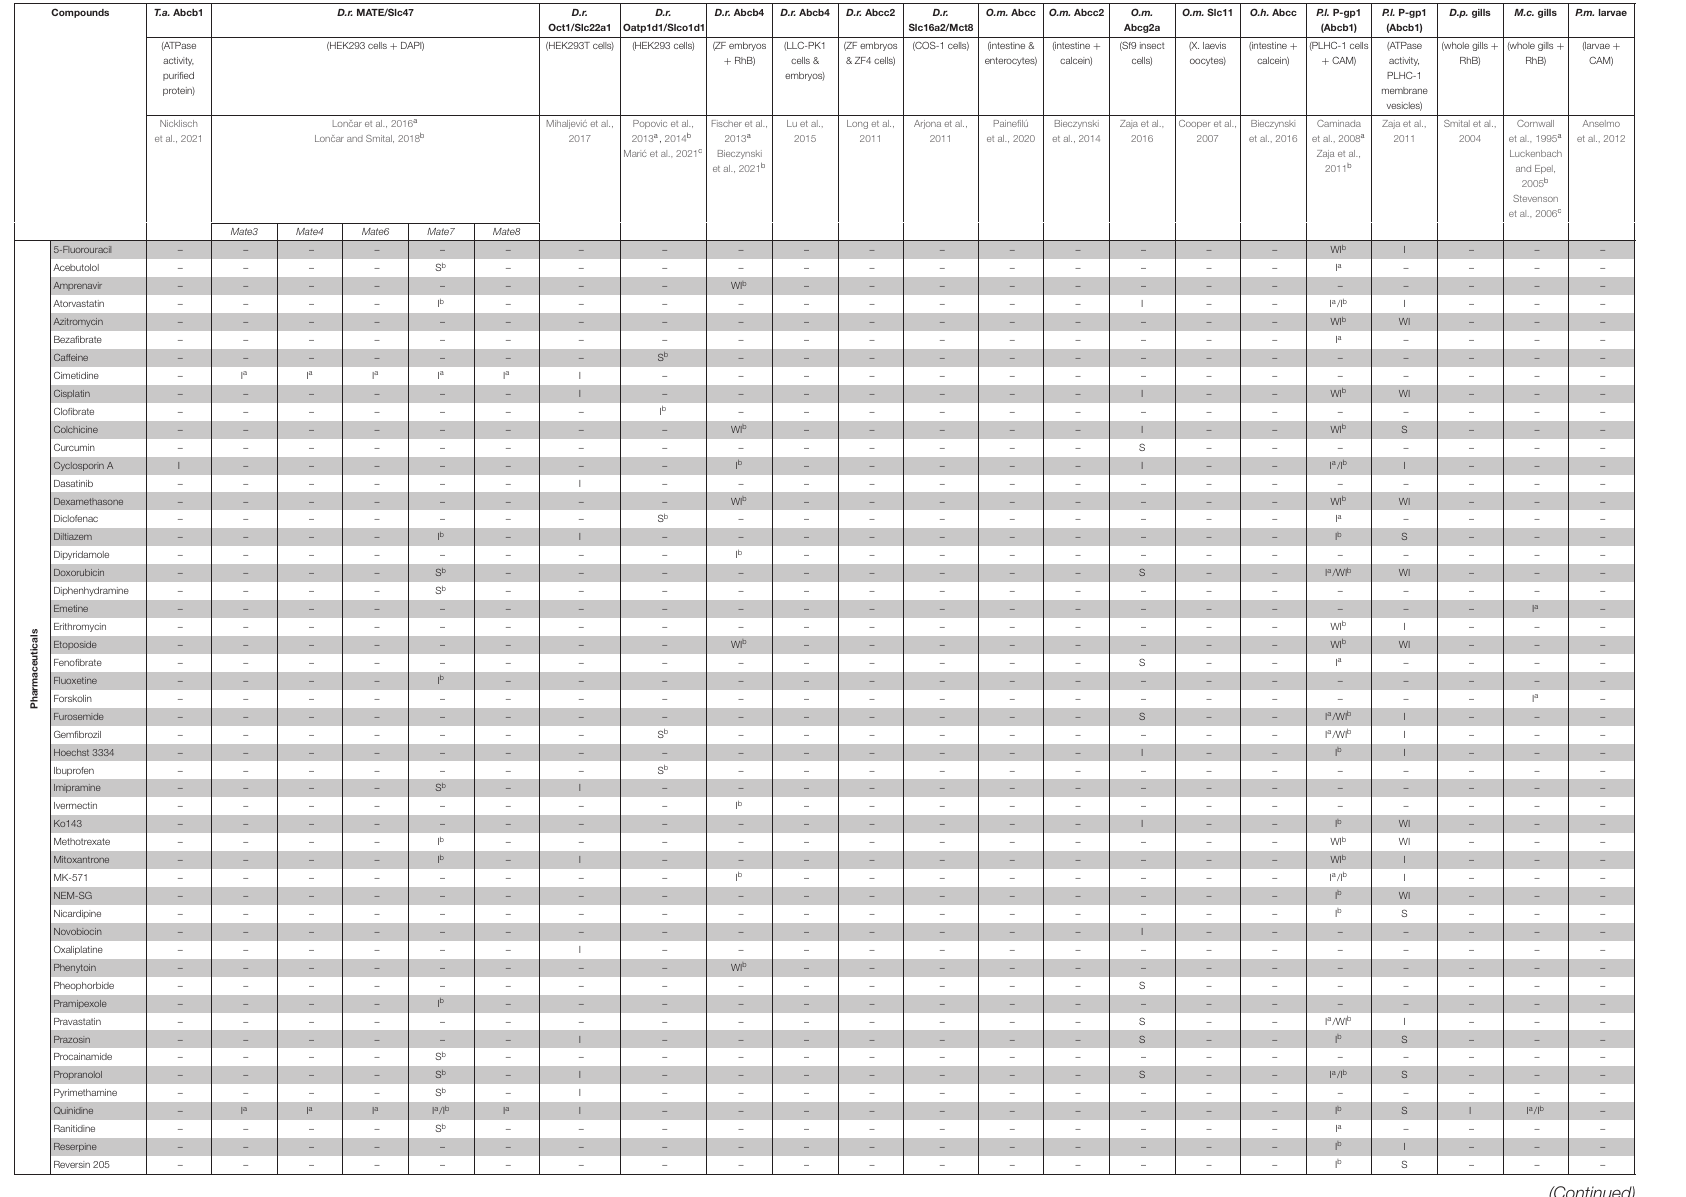
TABLE 2 | Summary of known xenobiotic interactions with MXR transporters in fish and aquatic invertebrates.